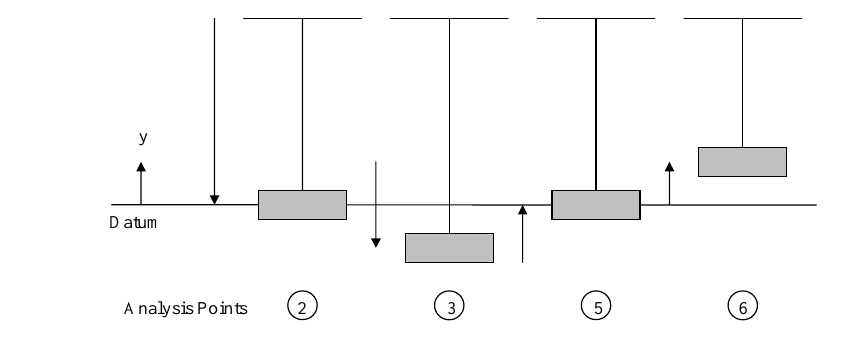
Fig. 5. Schematic of taut phase in dynamic test.